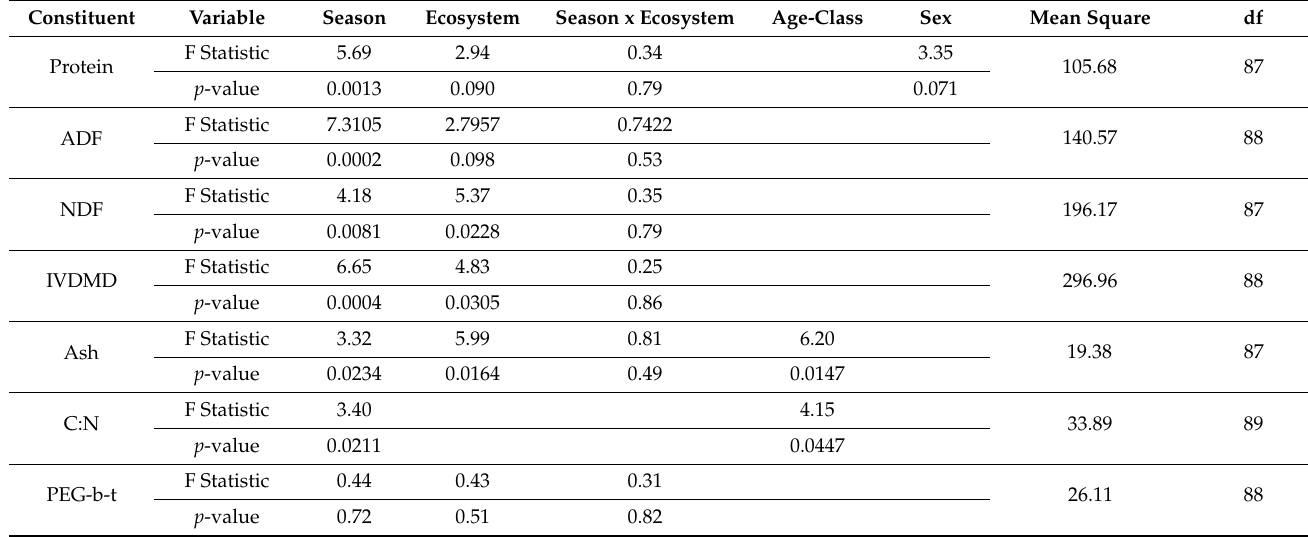
Table 5. Main details of two-way ANOVA tests for nutritional constituents in samples from mountain gazelle rumens, predicted by near-infrared spectrometry.